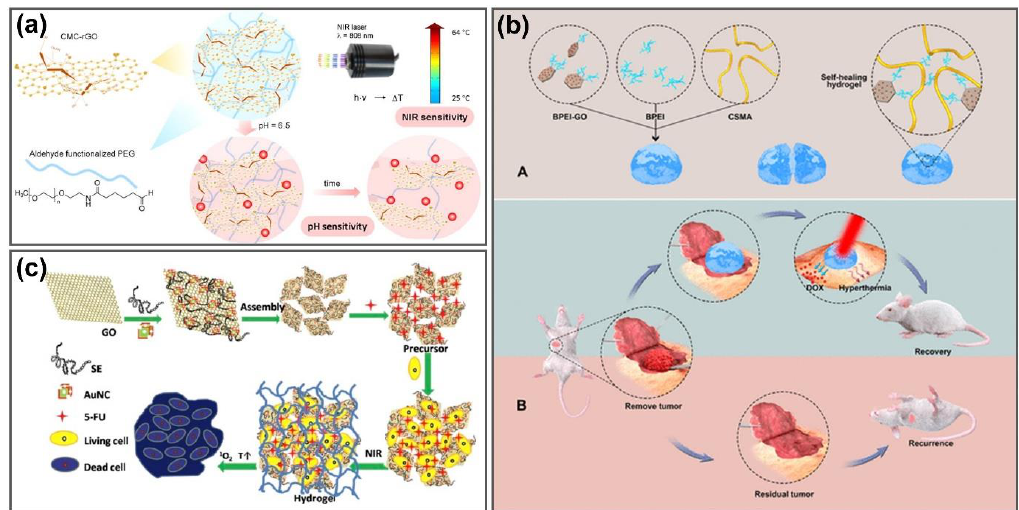
Figure 7. GGels for synergistic PTT. ( a ) Fabrication of carboxymethyl chitosan-functionalized GO hydrogels for chemo- photothermal synergistic therapy system with efficient drug release upon dual stimulation of NIR light and pH. Adapted with permission from [39]. ( b ) Development of CSMA/BPEI/BPEI-GO hydrogels for synergistic chemo-PTT to prevent locoregional recurrence of breast cancer. Adapted with permission from Ref. [129] . ( c ) Formation process of rGO/AuNCs/SE hydrogel synthesis, 5-FU drug loading and combined photothermal/photodynamic/chemo synergetic antitumor. Adapted with permission from [137] .